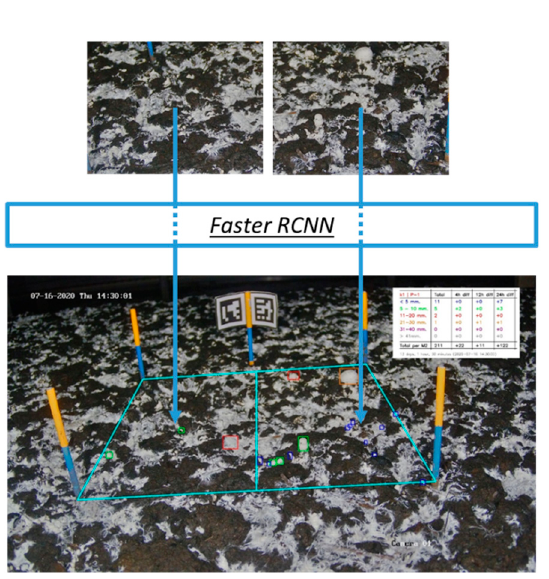
Figure 8. Scheme for the application of the object detection model and its results.